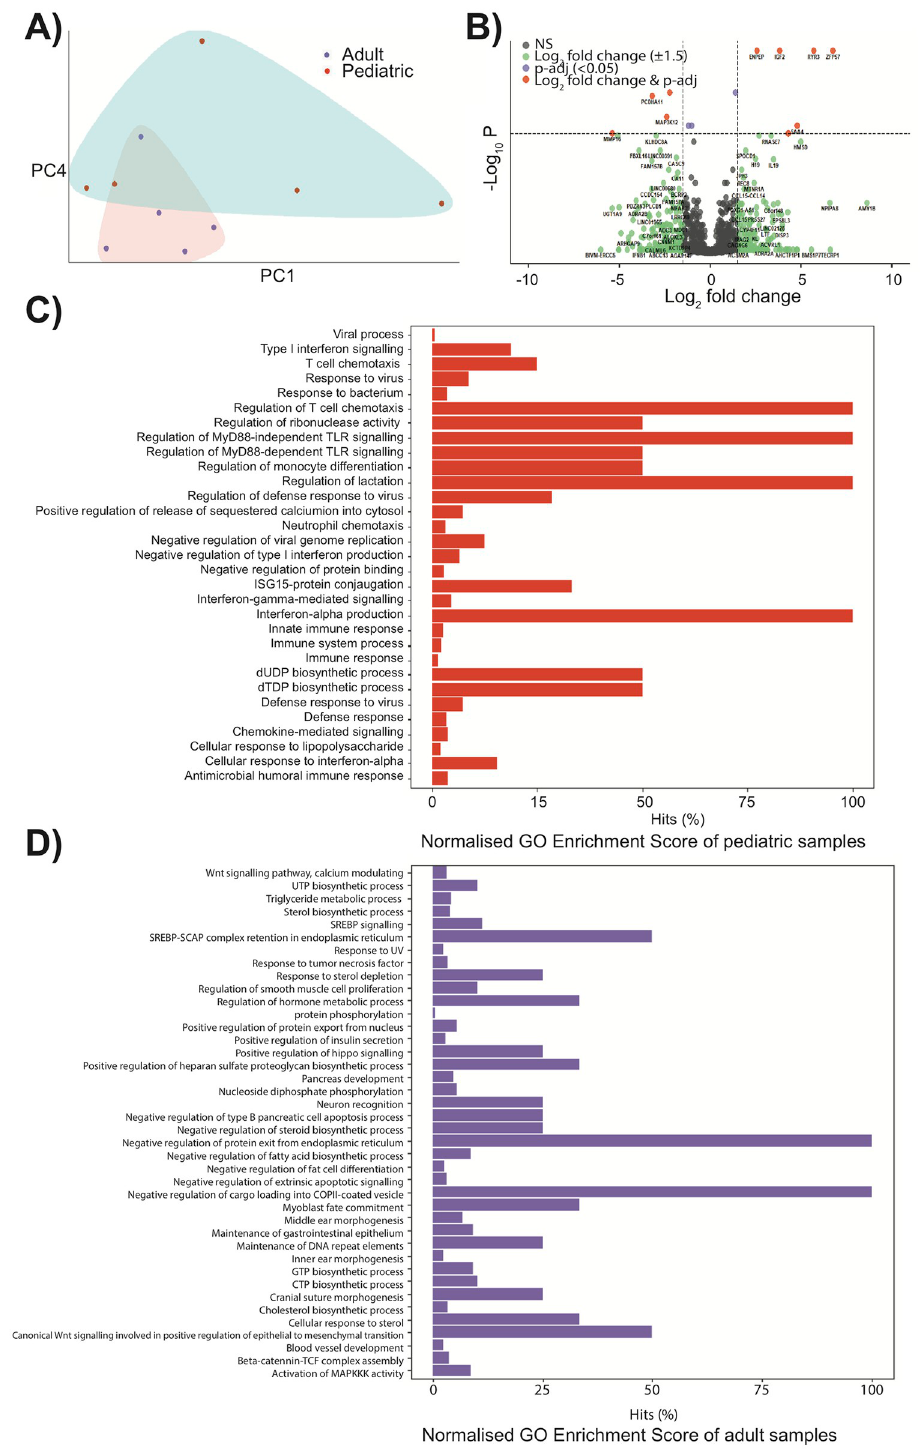
Fig 3. Pediatric epithelial cells have a different transcriptional response to SARS-CoV-2. ( A ) Principal component analysis for the global transcriptional response of naive pediatric and adult NECs. Data points represent individual donors ( N = 5 adults: 4 females, 1 male and N = 5 pediatric donors: 2 females, 3 males). ( B ) Volcano plot illustrating DEGs of infected pediatric NECs compared to adult cells. DEGs statistically different between the 2 patient groups with a fold change of > 1.5 are indicated in orange. DEGs statistically different between 2 groups with a fold change of